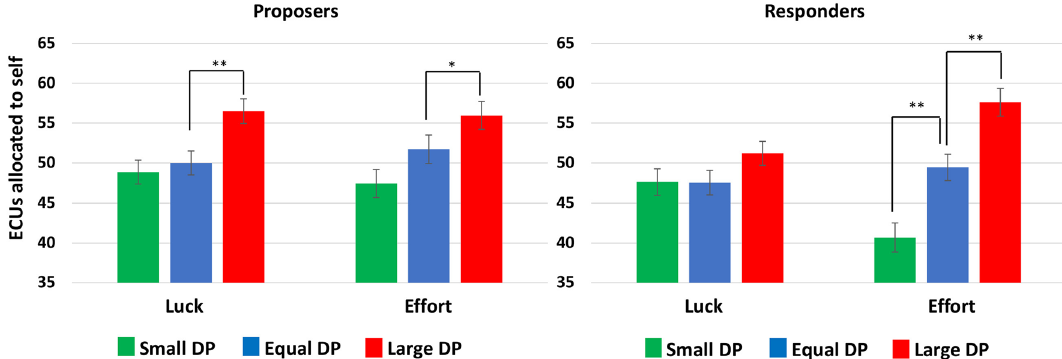
Figure 1. Share of self-allocated surplus (in ECUs) that is considered fair across power and merit conditions. Error bars represent standard error of the mean. Significant differences between equal-DP and large-DP or small-DP conditions are represented by asterisks: ** p < 0.01, * p < 0.05.